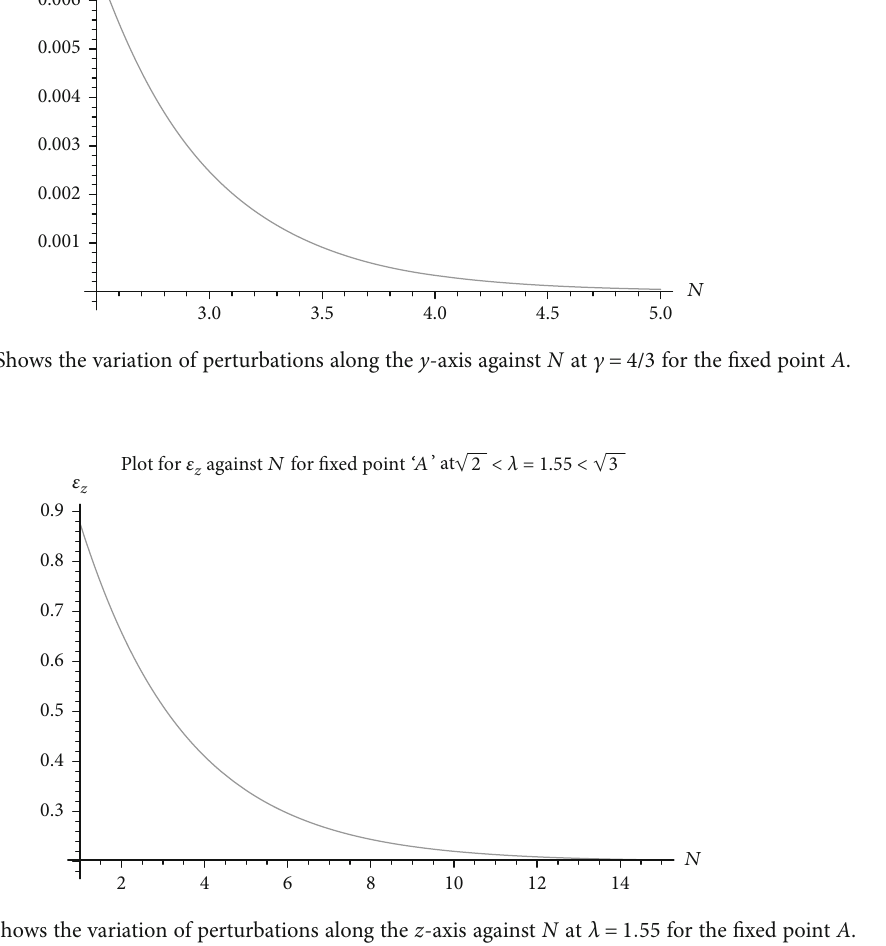
Figure 12: Shows the variation of perturbations along the z -axis against N at λ = 1 : 55 for the fi xed point A